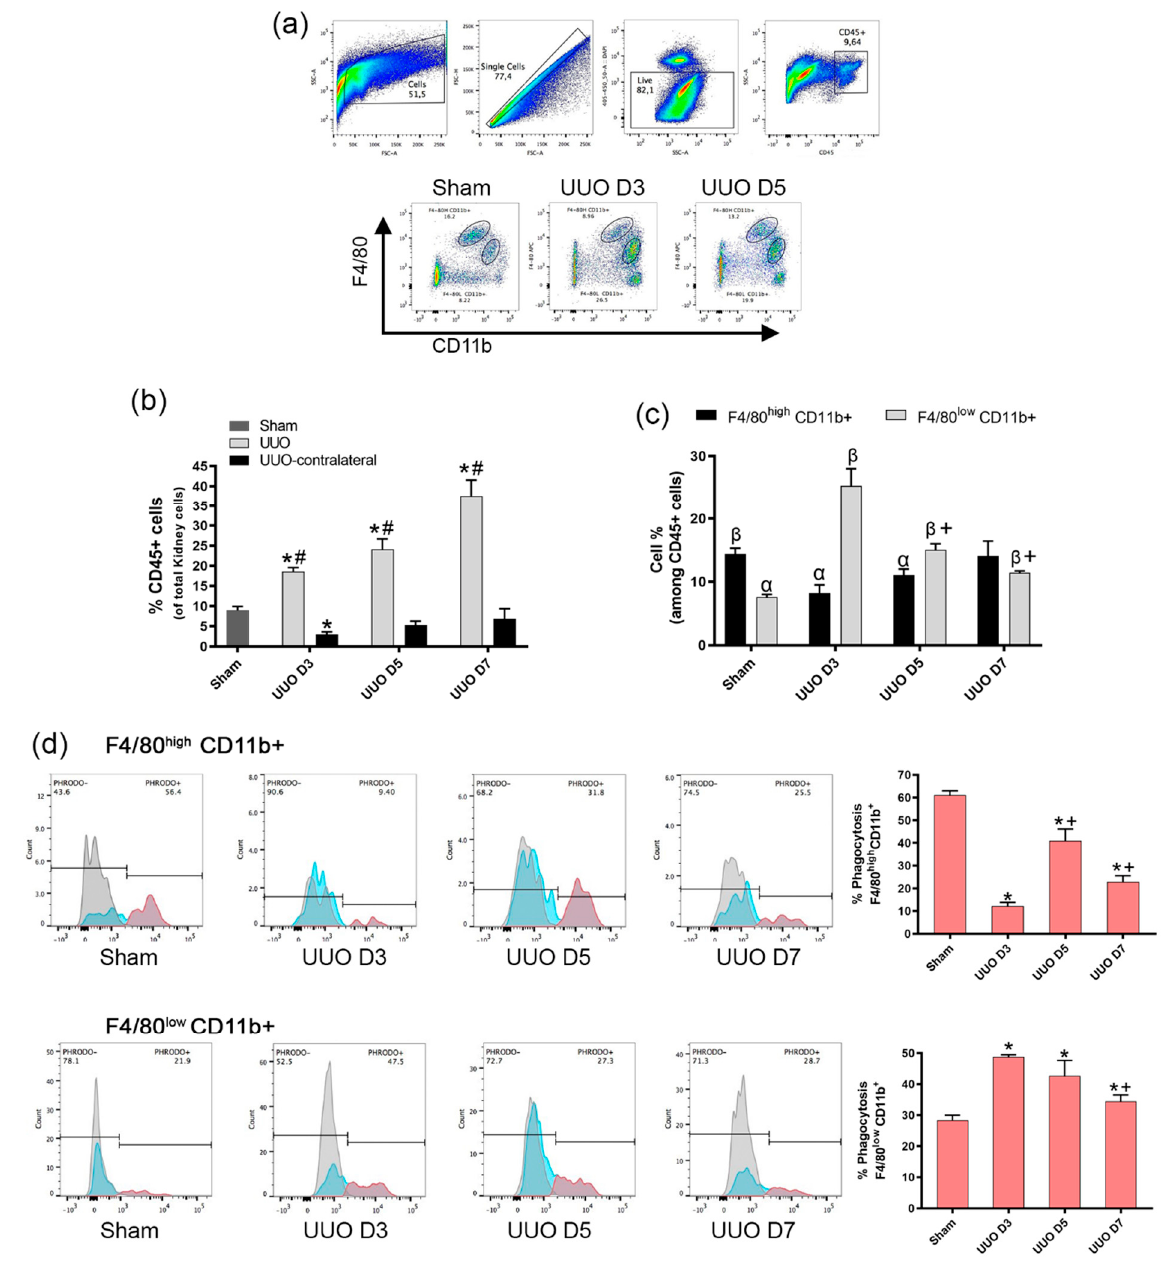
Figure 2. Macrophage phagocytosis analysis during the evolution of fibrosis in the Unilateral Ureteral Obstruction model in mice. Flow cytometry analysis of cells isolated from mice kidney at day 3, 5 and 7 after UUO. Cells isolated from the kidney of sham operated mice were used as control. ( a ) Gating strategy to characterize macrophage population. Live cells (DAPI − ) were gated on CD45+ population for analysis of dual expression of surface markers CD11b and F4/80 (oval circles) in the whole kidney at the different time points. ( b ) Percentage of CD45+ cells and macrophage populations ( c ) F4/80 high − CD11b+ and ( d ) F4/80 low − CD11b+ at the indicated times. ( d ) Representative analysis of macrophage (defined by gating on CD45+ F4/80 low − CD11b+ and F4/80 high − CD11b+) phagocytosis of 120 µg/mL pHrodo green E. coli bioparticles for 90 min, at the different time points following UUO. Data presented as mean ± SEM; n = 4–6 per group from three independent experiments; * p < 0.05 vs. sham, # p < 0.05 vs. UUO-contralateral, + p < 0.05 vs. UUO D3. α p < 0.05 vs. Sham F4/80 high CD11b+. β p < 0.05 vs. Sham F4/80 low CD11b+.